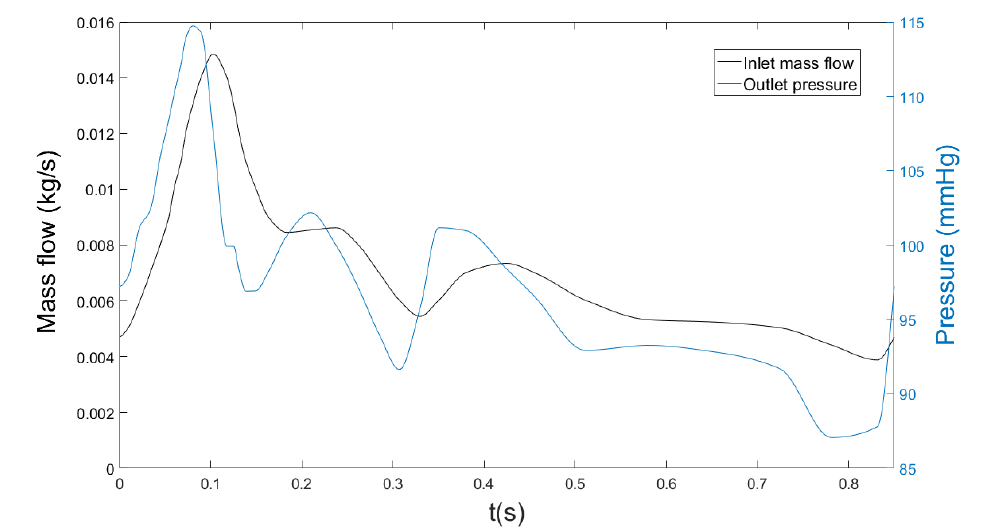
Figure 2. Mass flow (black line) and pressure (blue line) imposed as boundary conditions at the inlet and outlet of the geometry, respectively